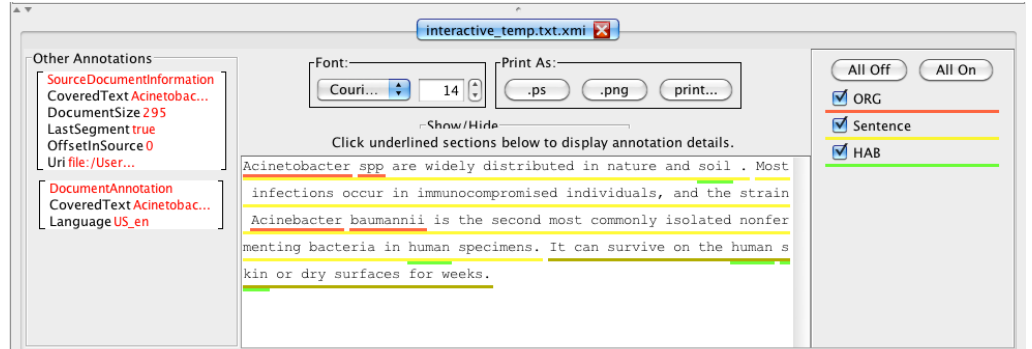
Figure 2: The result of our workflow on extraction of microorganisms and habitats in U-Compare Figure 2 shows the result of our text-mining workflow on this excerpt. All the microorganisms are underlined in red, the habitats are underlined in green and the relation-indicating sentences are underlined in yellow. The workflow underlines sentences in yellow if and only if it contains both microorganisms and their habitats, thus highlighting host-associated habitats from non- host-associated